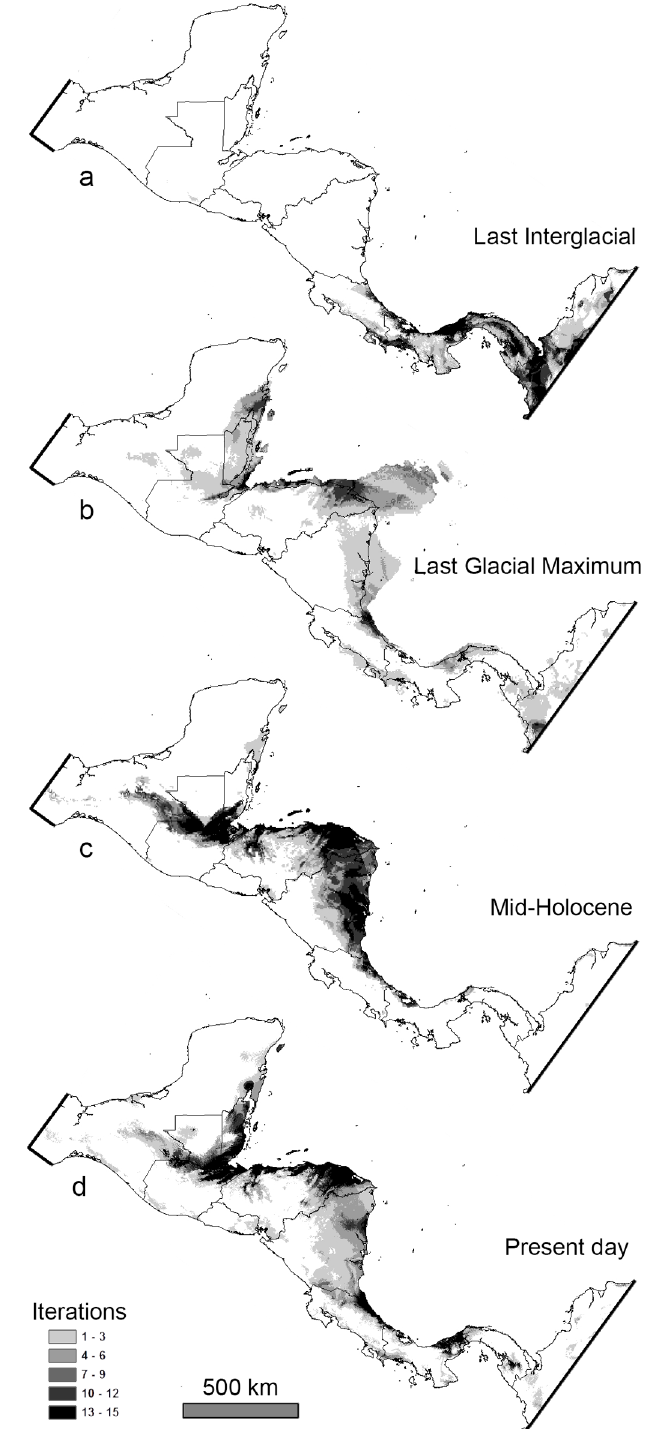
Fig 3. Paleodistribution models (a, Last Interglacial; b, Last Glacial Maximum; c, mid-Holocene) and d, present-day ecological niche model for Vieja maculicauda . Darker areas indicate presencein more iterationsof the model and therefore the highestprobabilityof occurrence. For the LGM model, extended coastlinesare a result of lower sea levels.